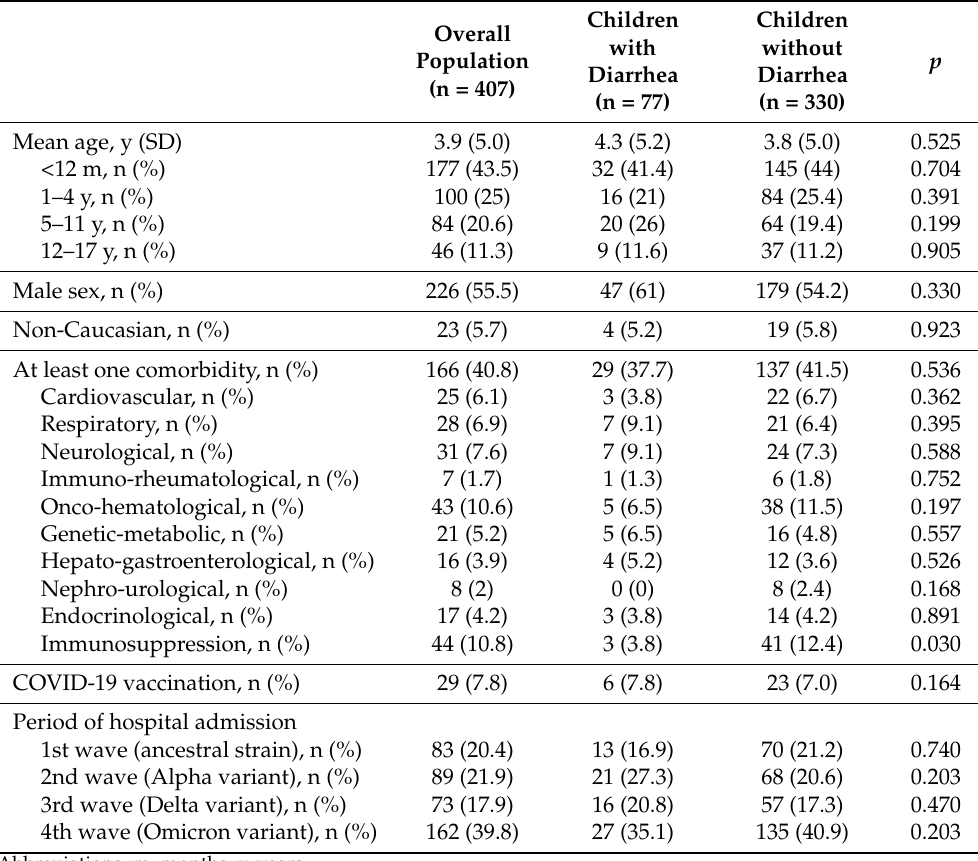
Table 1. Demographic features of enrolled